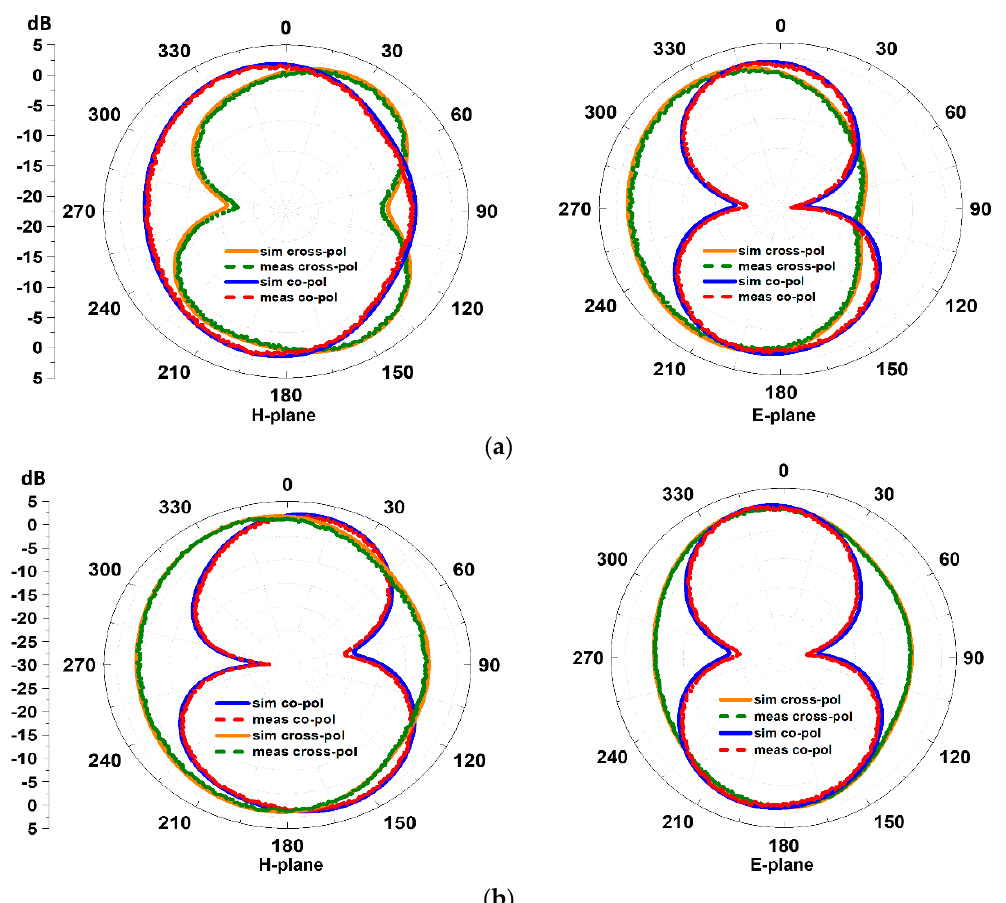
Figure 9. Radiation pattern measurement setup.